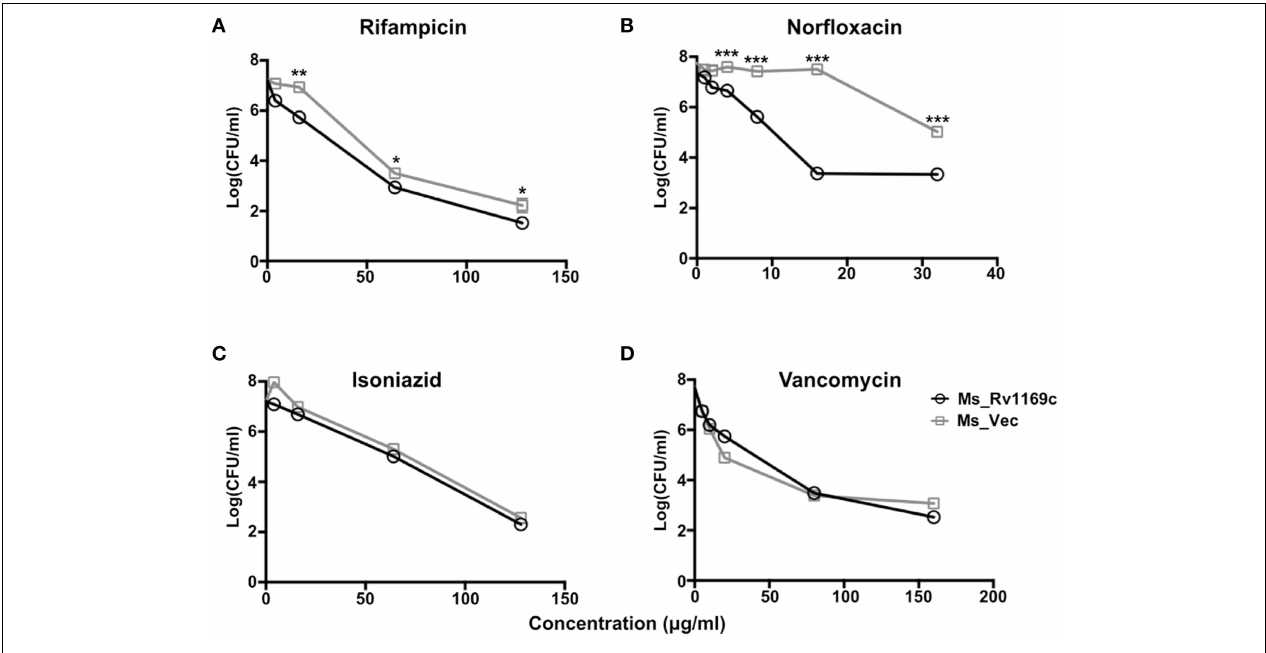
FIGURE 4 | The survival of Ms_Vec and Ms_Rv1169c after treatment with different antibiotics, including Rif (A), Nor (B), INH (C), and Van (D). Ms_Vec and Ms_Rv1169c were exposed to Rif, Nor, INH and Van, and